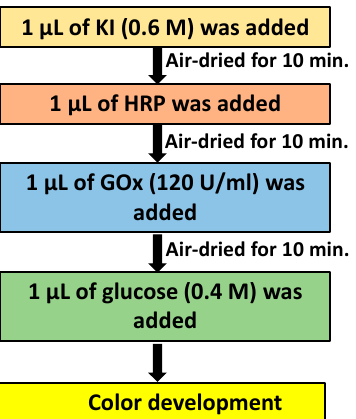
Figure 5. Schematic representation of the reaction mechanism for the colored product formation using oxidase enzymes.